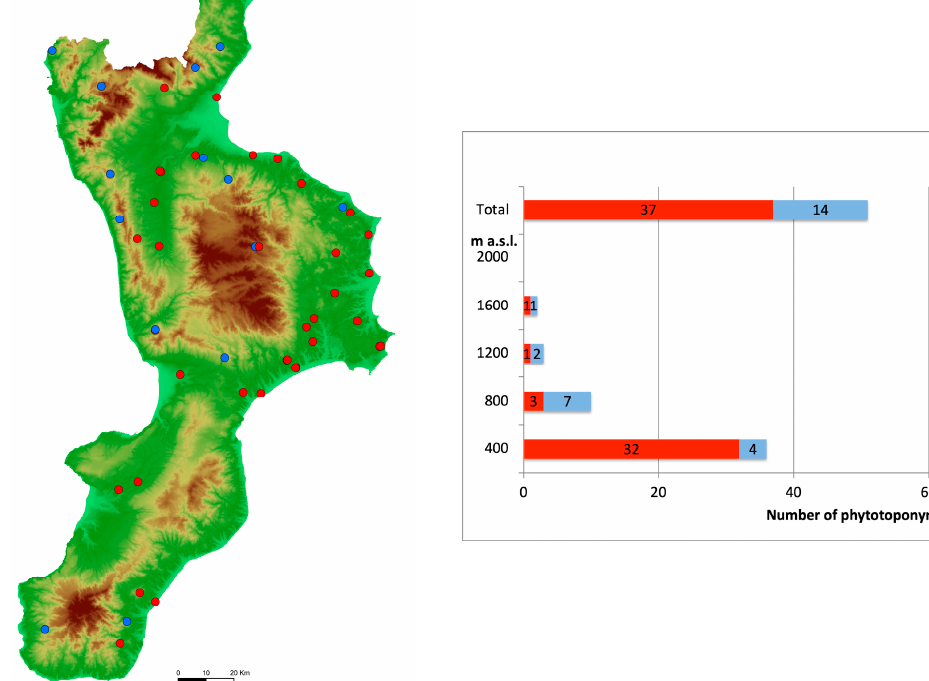
Figure 10. Distribution of phytotoponyms related to Fraxiunus angustifolia Vahl subsp. oxycarpa (M.Bieb. ex Willd.) Franco & Rocha on map and by altitudinal belt. Blue, agreement with current forest vegetation; red, no agreement .